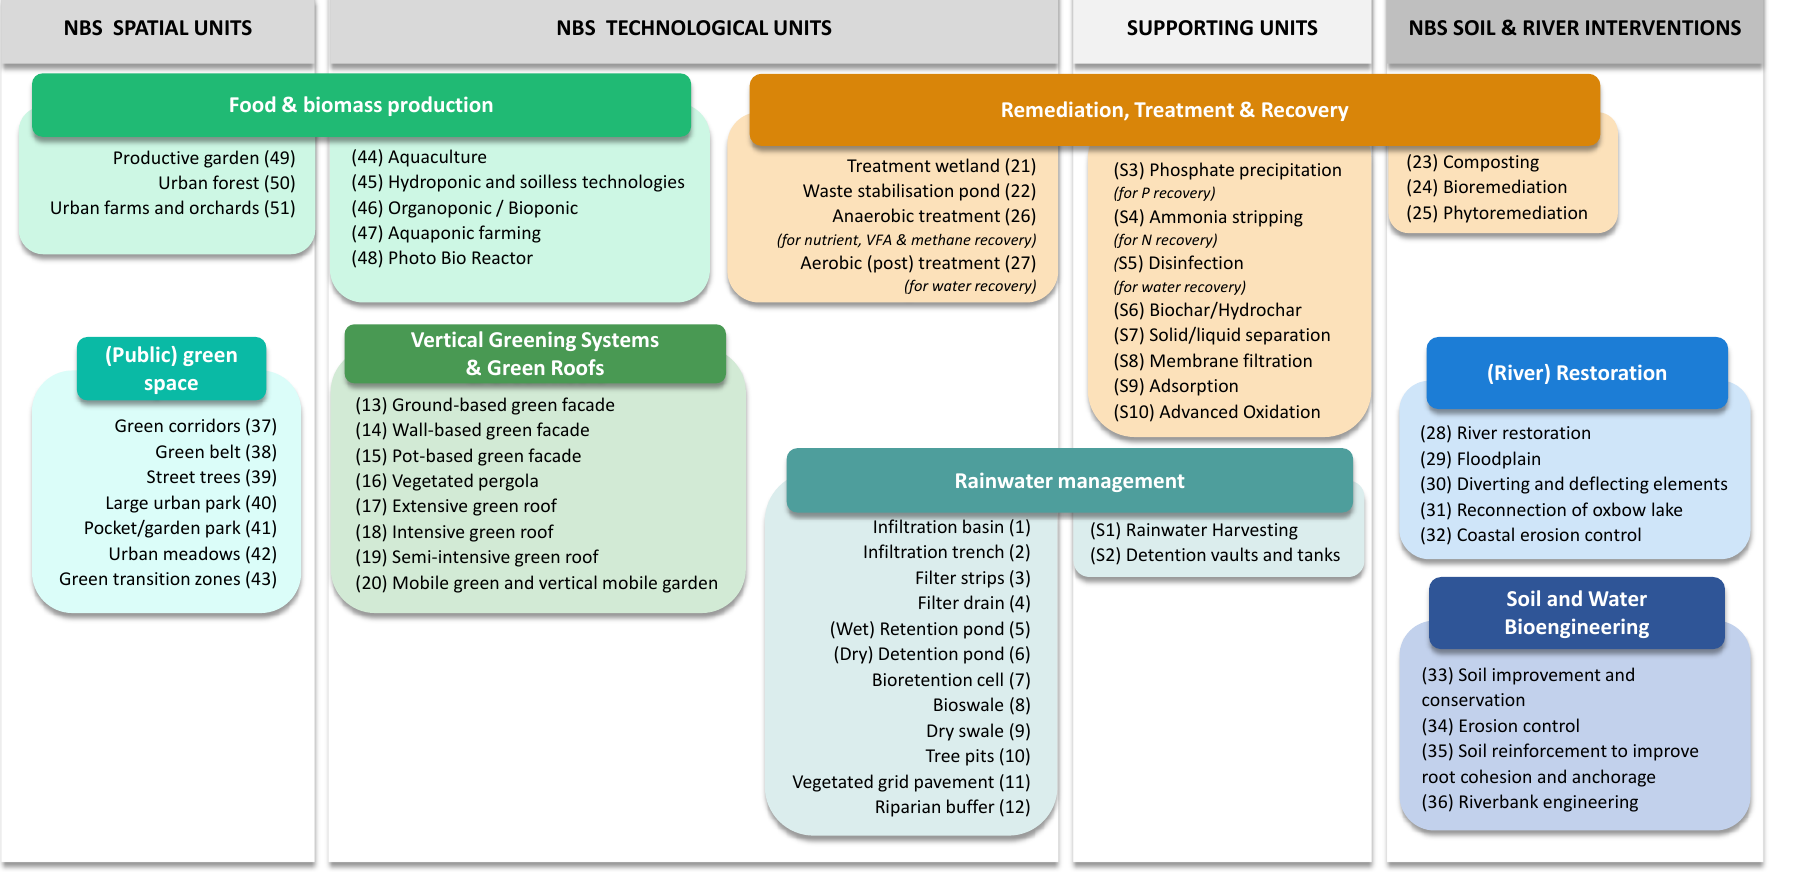
Figure 2. NBS units (NBS_u), NBS interventions (NBS_i), and Supporting units (S_u) clustered into categories (dark gray squares, adapted from [15] and sub-categories proposed by consulted experts within the COST Action Circular City (colored squares).